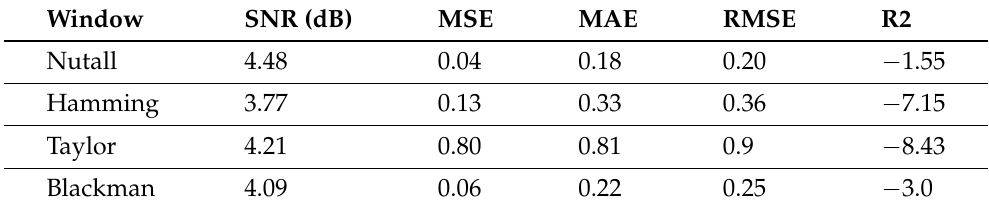
Table 3. EMG signal statistical analysis and FIR